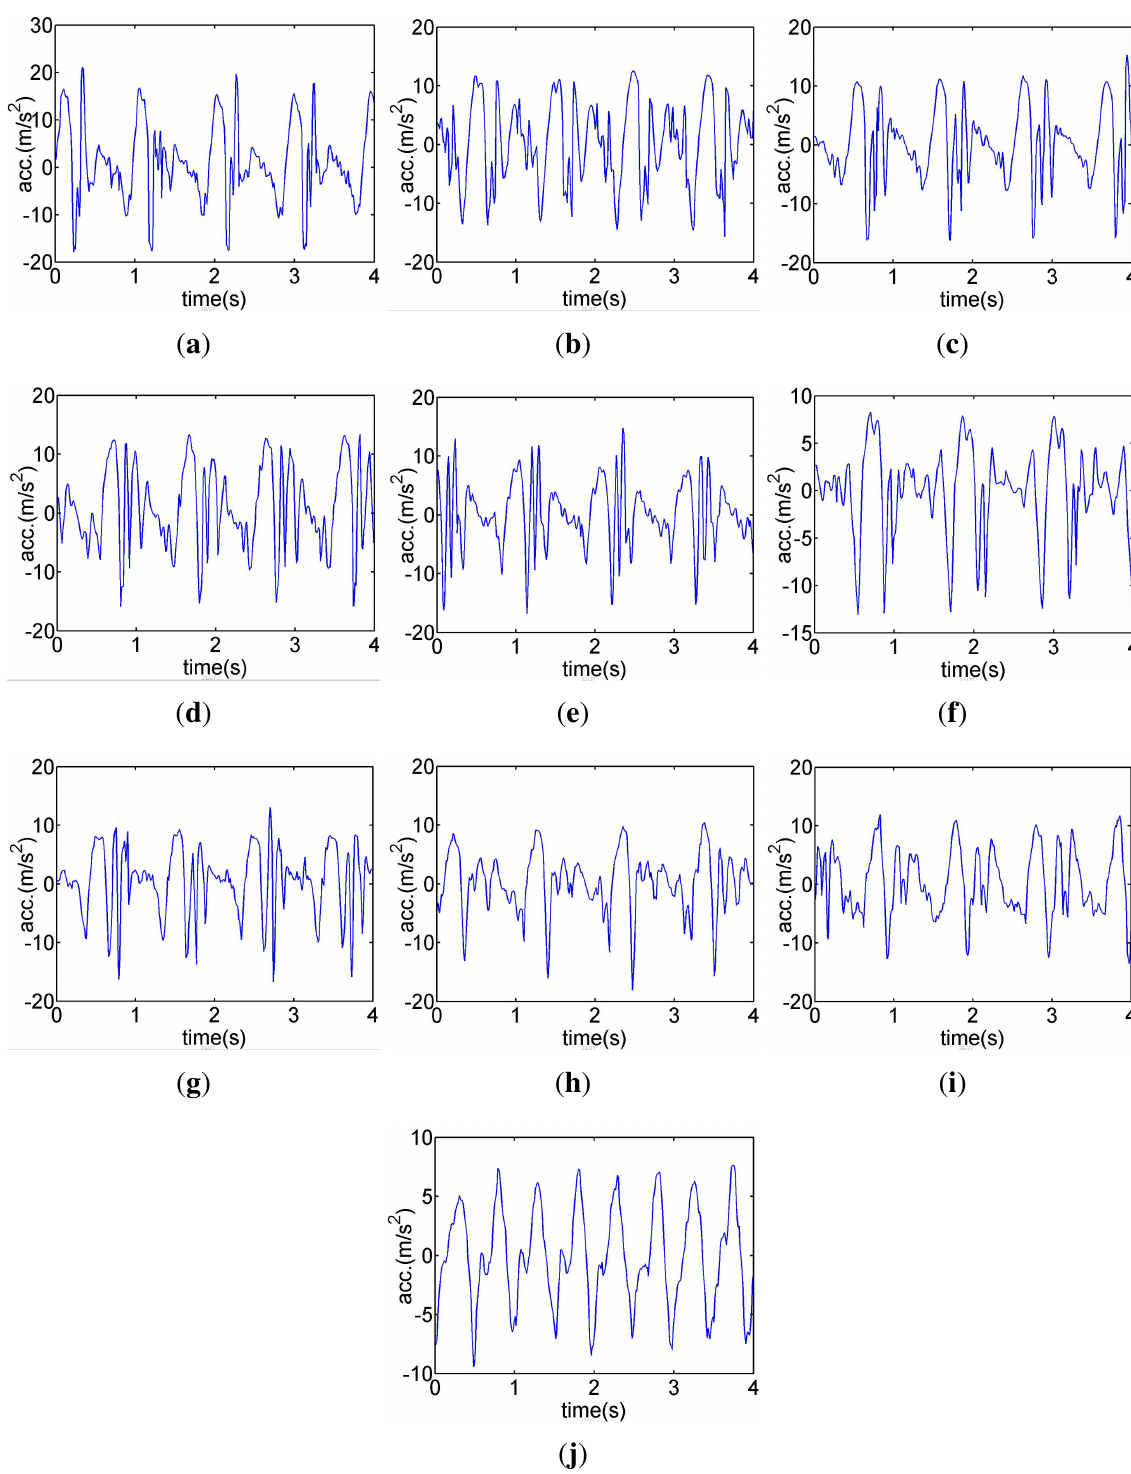
Figure 8. Characteristics curves of ten tested persons as the